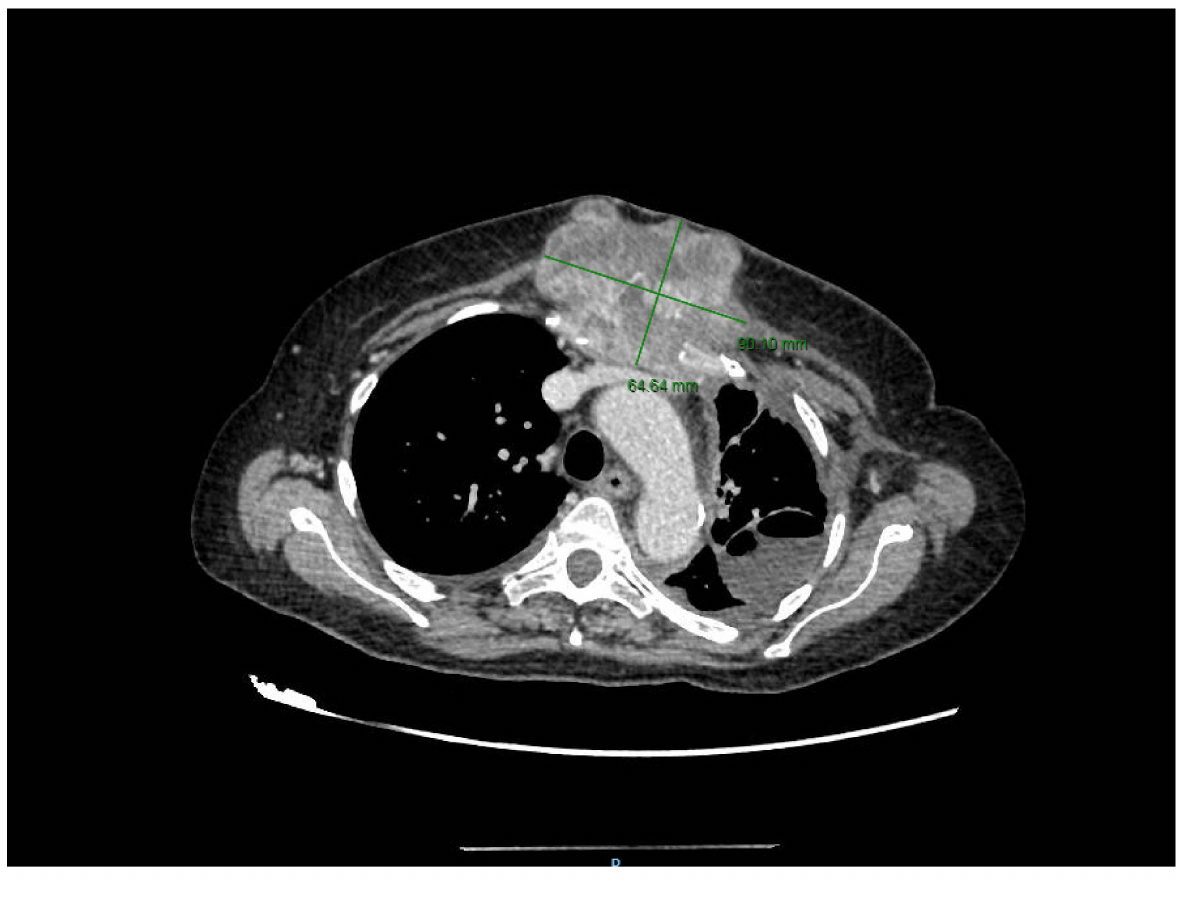
Figure 2. Initial CT aspect.